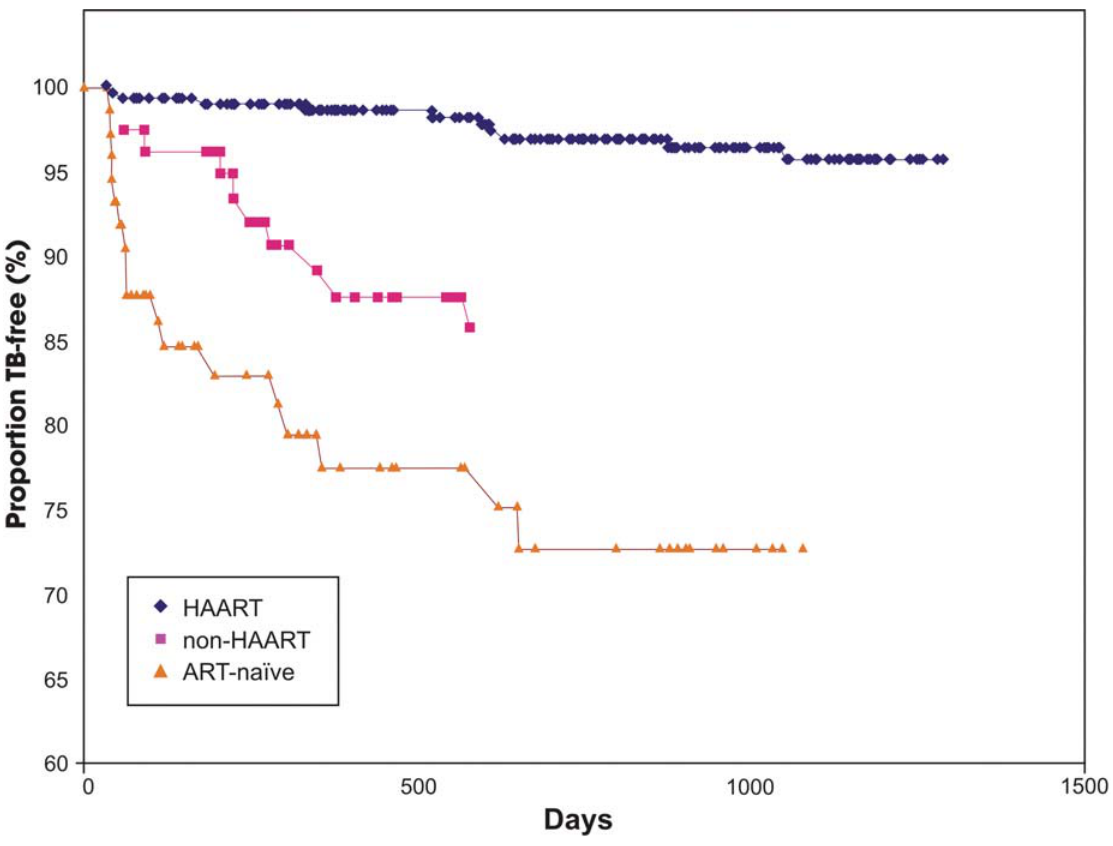
Figure 2. Kaplan-Meier survival curve* of the proportion of patients attending public HIV treatment facilities in Brazil (n=463) between January 1, 1995 and December 31, 2001 who remained TB free at primary study endpoint (i.e., TB, death, or last clinic visit) over the time course (in days) of the study period, by intervention (HAART, ART non-HAART), and non-intervention (ART naı¨ve). doi:10.1371/journal.pone.0000826.g002 PLoS ONE |